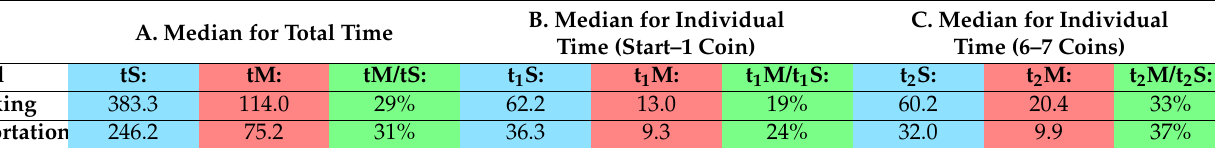
Table 3. Comparison of the median time for walking and teleportation.